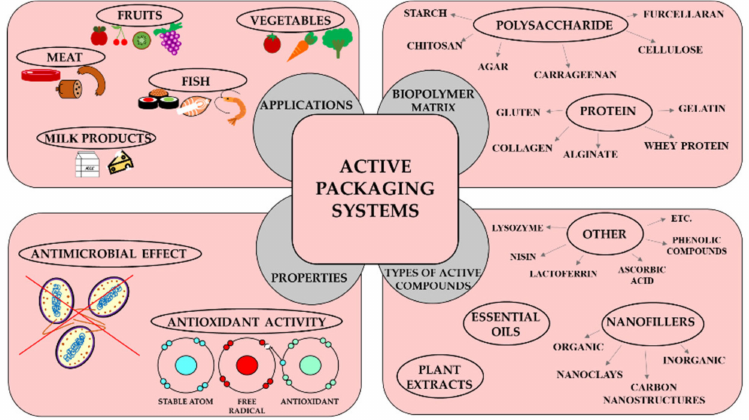
Figure 1. The active properties of biopolymer films as the main compounds in active packaging